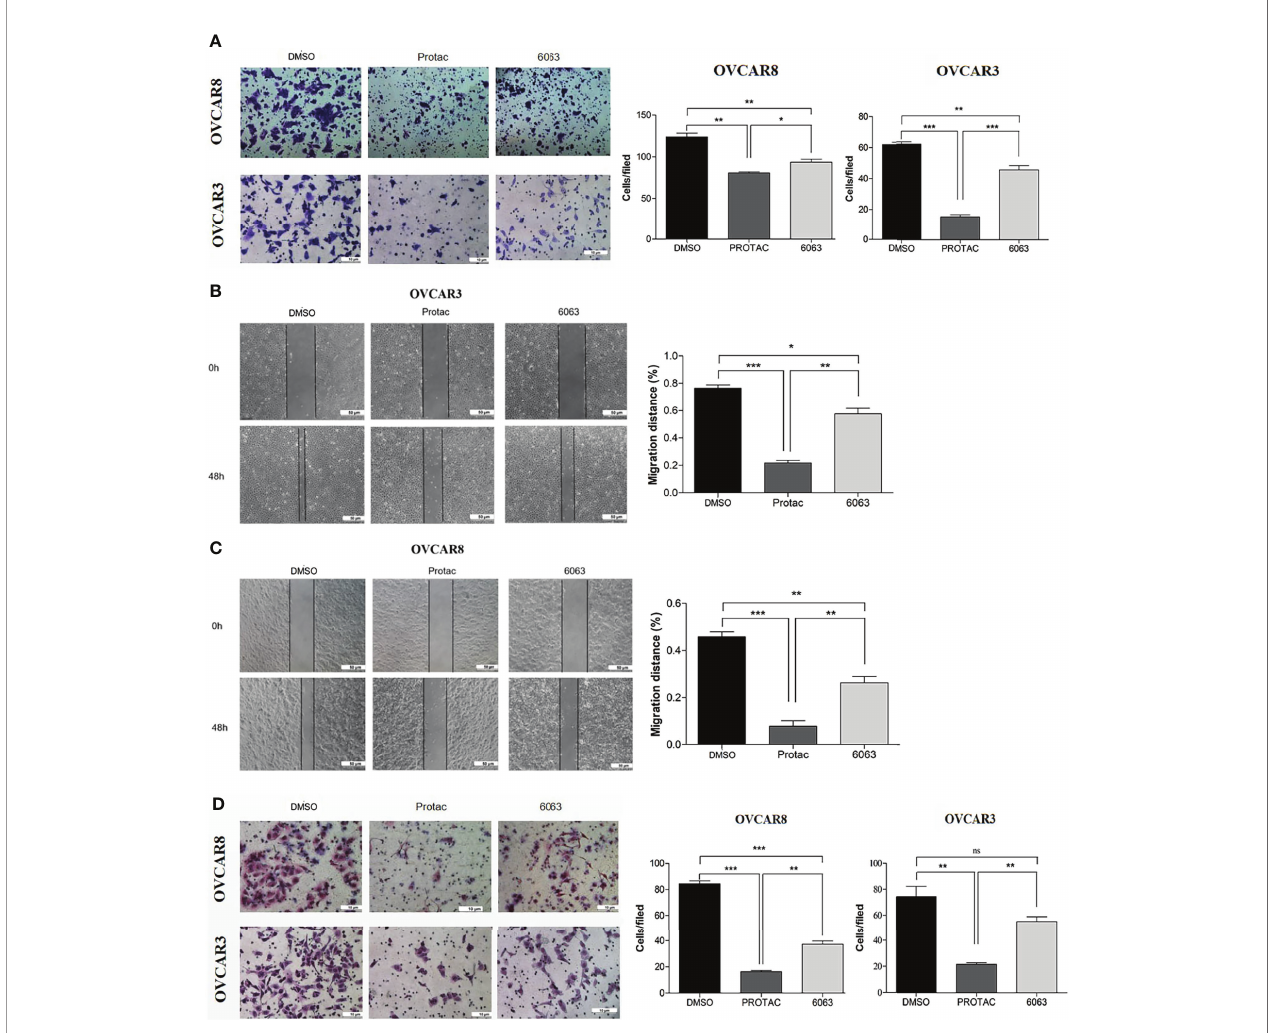
FIGURE 4 | FAK PROTAC is more effective in inhibiting OC cell migration and invasion. (A – C) Cell migration in both OVCAR3 and OVCAR8 was examined using transwell plates (A) and wound healing assays (B, C) . Migrated cells in transwells were stained with crystal violet and counted from three different fi elds under microscopy. Migration in wound healing assay was calculated by comparing migrated distance at 48h to 0h. (D) . Invasion in OVCAR3 and OVCAR8 was examined using Matrigel coated transwell plates following 4h treatment with 1µM PROTAC or VS6063 and compared to vehicle treated cells. (* p< 0.05; ** p <0.01; *** p <0.001; ns, not signi fi